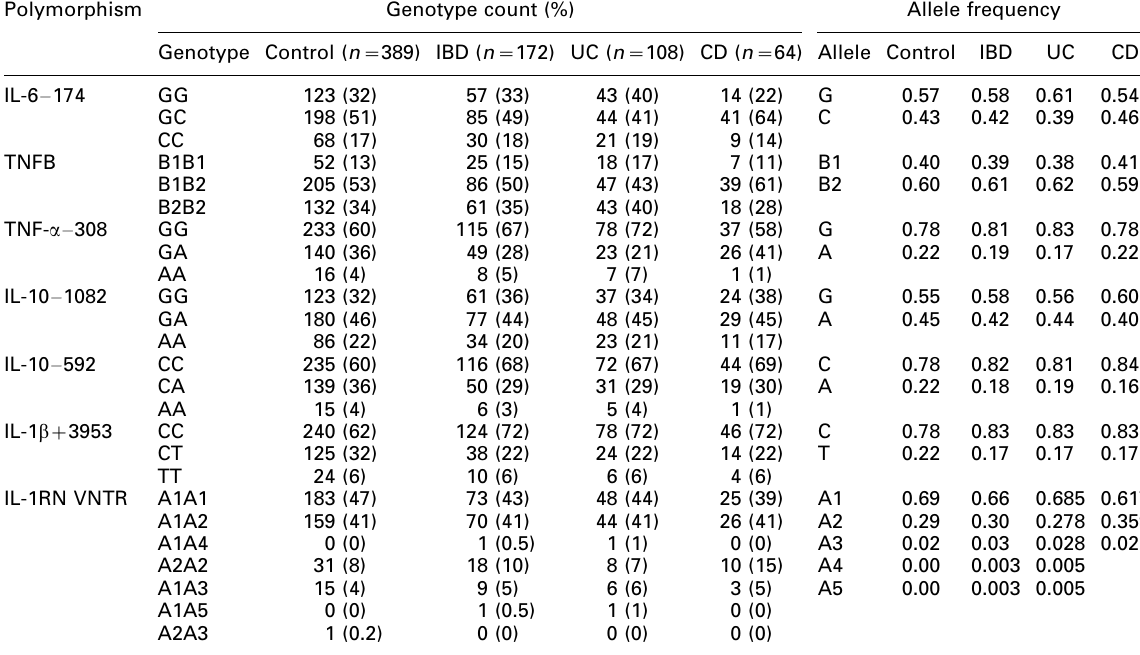
Table 4. Genotype counts (%) and allele frequencies of seven polymorphisms in a control population and an IBD patient population, and in subdivisions of the IBD population (UC and CD groups)